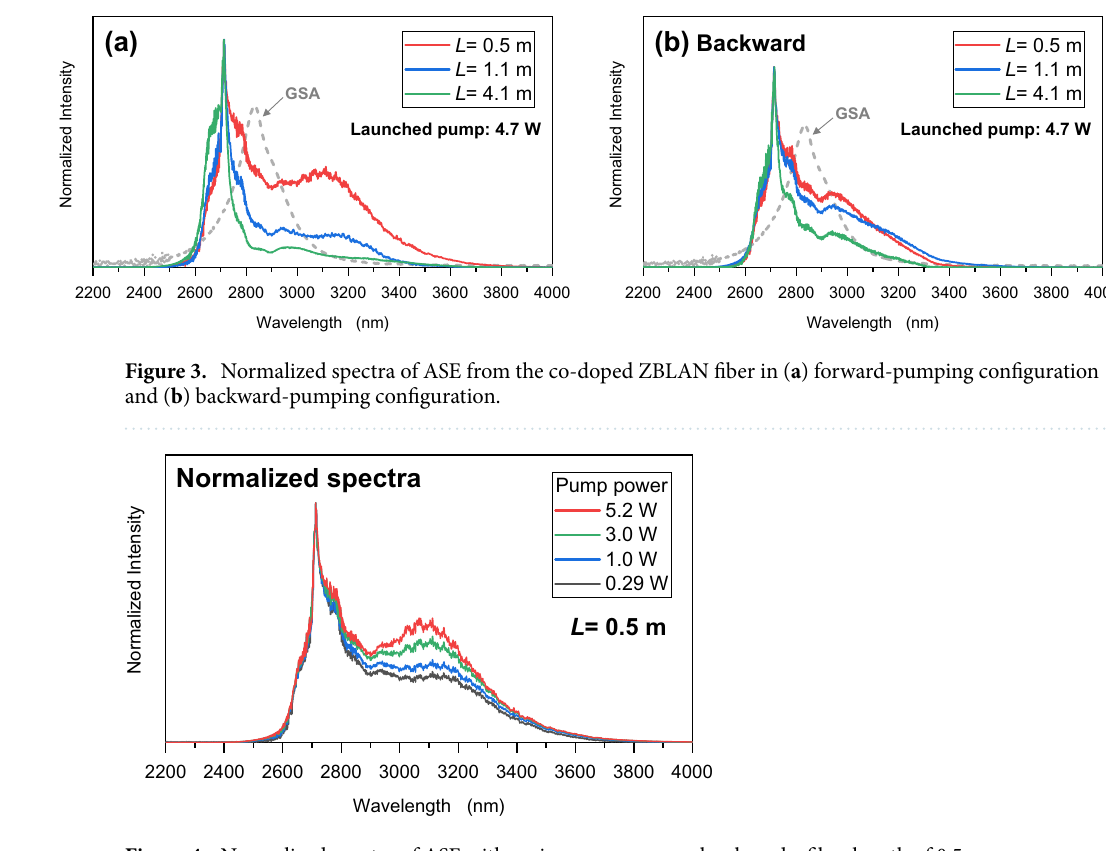
Figure 4. Normalized spectra of ASE with various pump power levels and a fiber length of 0.5